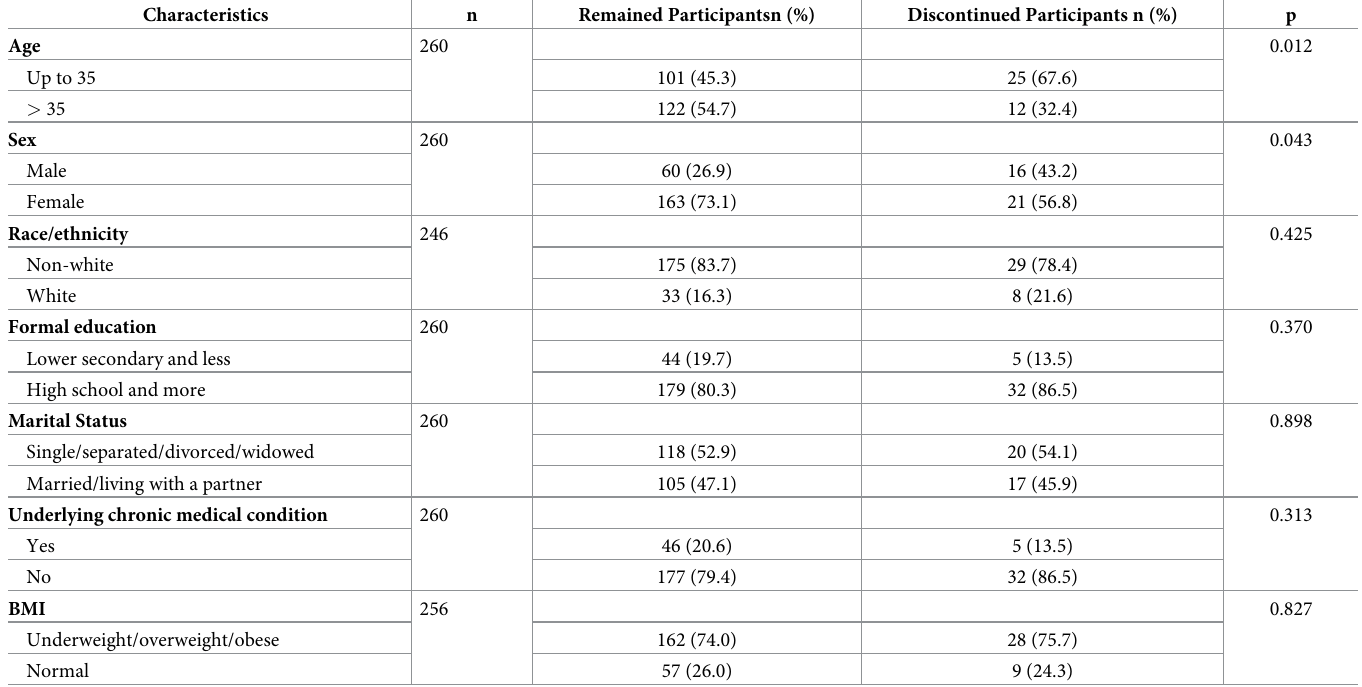
Table 6. Characteristics associated with discontinuation in the ZIKABRA cohort